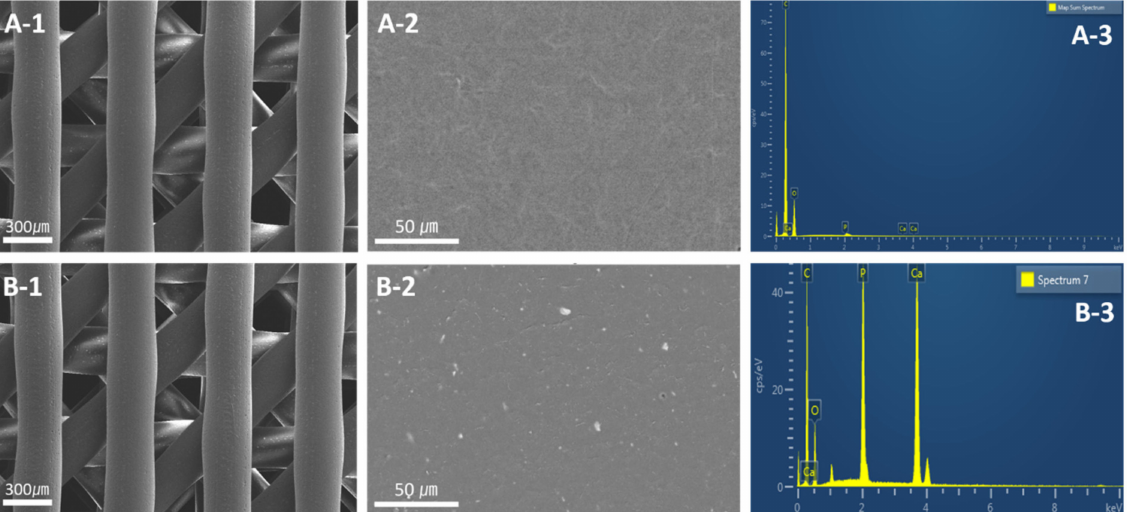
Figure 2. FE-SEM images and EDS analysis of the ( A-1 ) 3D PCL scaffold, ( A-2 ) PCL scaffold surface, and ( A-3 ) EDS spectrum of PCL scaffold; ( B-1 ) 3D PCL/ β -TCP scaffold, ( B-2 ) PCL/ β -TCP scaffold surface, and ( B-3 ) EDS spectrum of PCL/ β -TCP